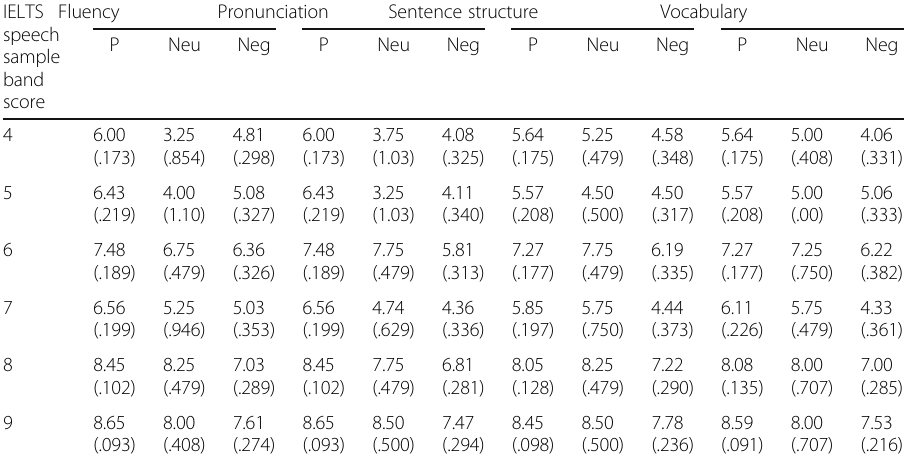
Table 3 Mean and standard deviation for all rating categories IELTS